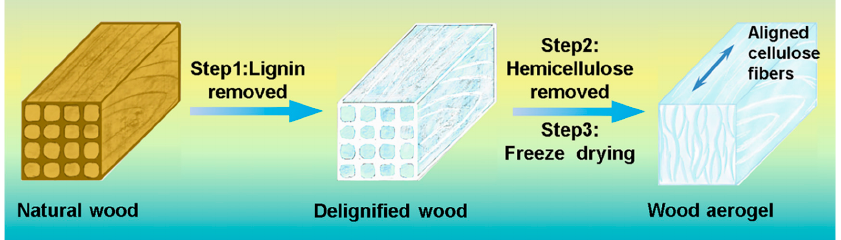
Figure 1. Schematic illustration of the fabricating of the wood aerogel.